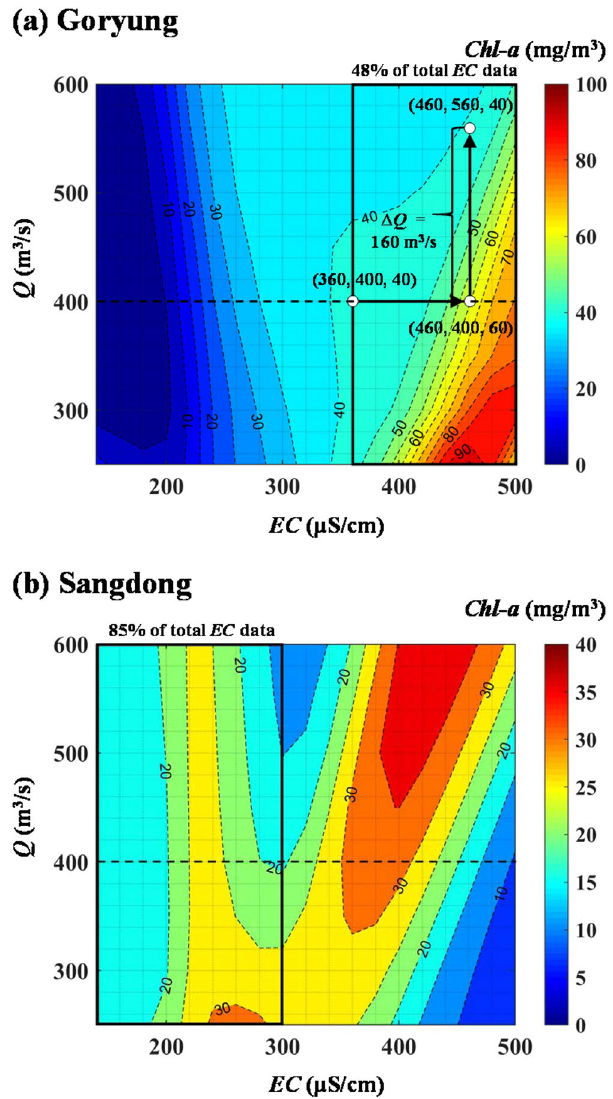
Figure 6. Response of Chl-a to increase in EC with different conditions of Q at Goryung station and Sangdong station, estimated by 3-cluster ANN models (a dotted line indicates the optimal level of Q derived from Figure